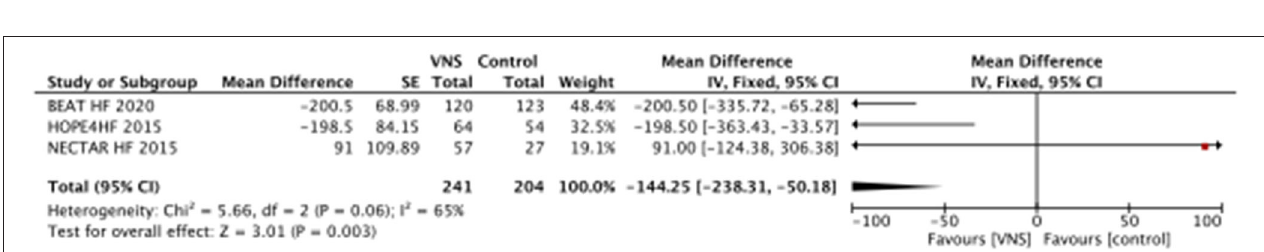
FIGURE 6 | Improvement of NT-proBNP levels during follow-up between VNS and control groups for management of chronic heart failure with reduced ejection fraction. VNS, vagus nerve stimulation.